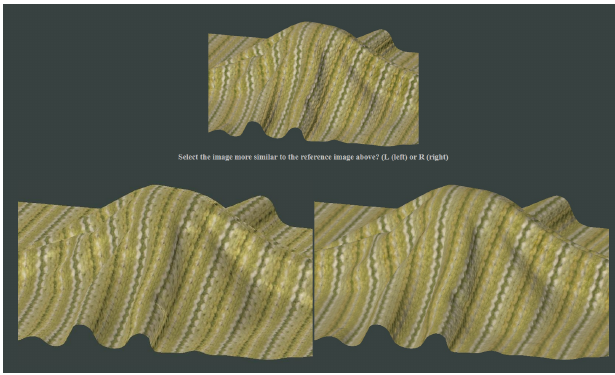
Figure 9. Example stimulus image from the second psychophysical